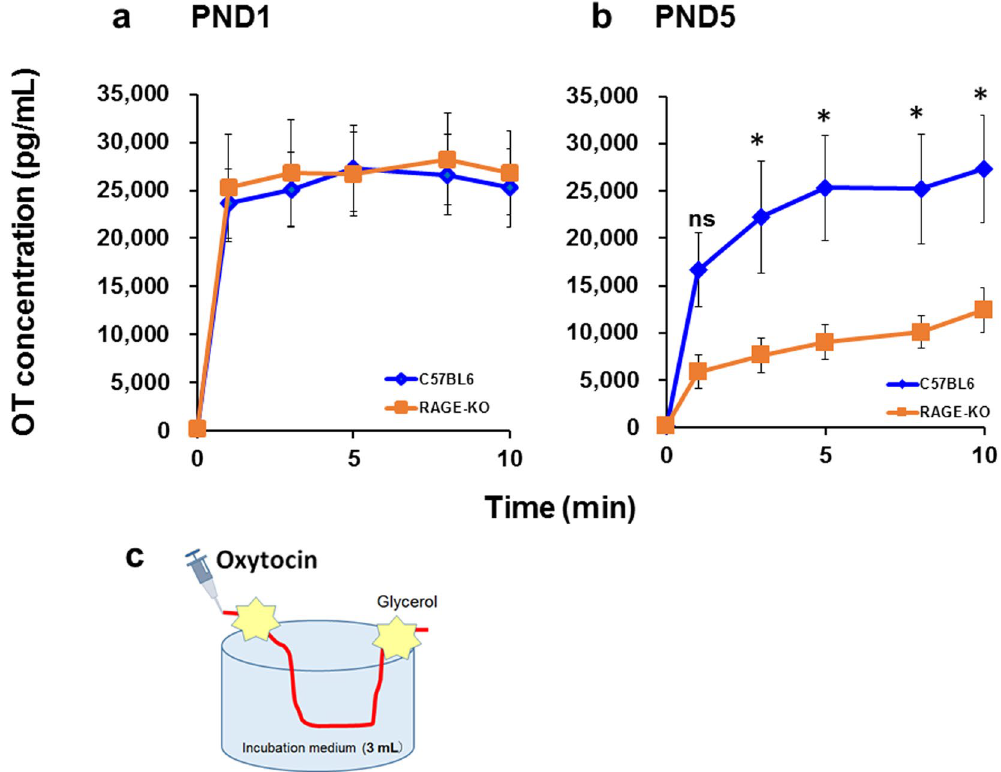
Figure 4. OT concentrations in incubation medium from isolated intestines. Time course of OT concentrations in incubation medium (3 mL) containing a segment of the intestine isolated from PND1 ( a ) or PND5 ( b ) wild-type (C57BL6, blue diamonds) and Ager − / − (RAGE KO; orange squares) pups. Fifty microlitres of 10 μ M OT was injected at the distal end after ligation. Fifteen microlitres of incubation medium was collected at the indicated time after injection of OT. In ( b ), two-way ANOVA for genotype effect, F 1,84 = 31.02, P < 0.0001 and for time effect, F 5,84 = 7.41, P < 0.0001. Bonferroni’s post hoc tests revealed significant differences between wild- type and KO mice at * P < 0.05. ( c ) The scheme illustrates the incubation of the isolated intestines.